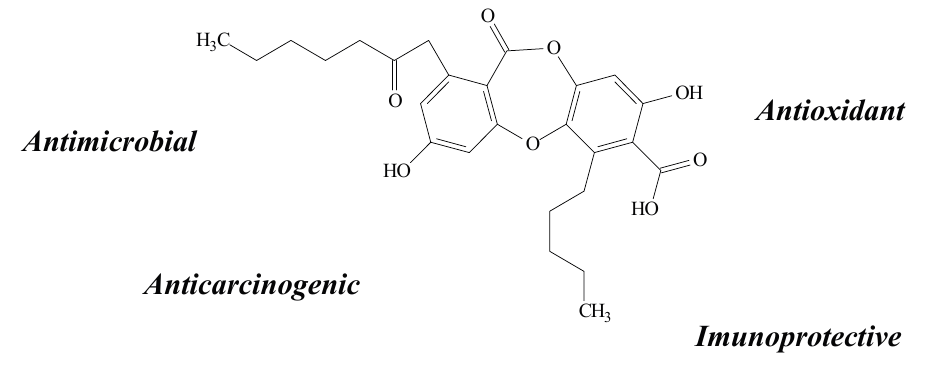
Figure 10. Physodic acid structure and biological activities.